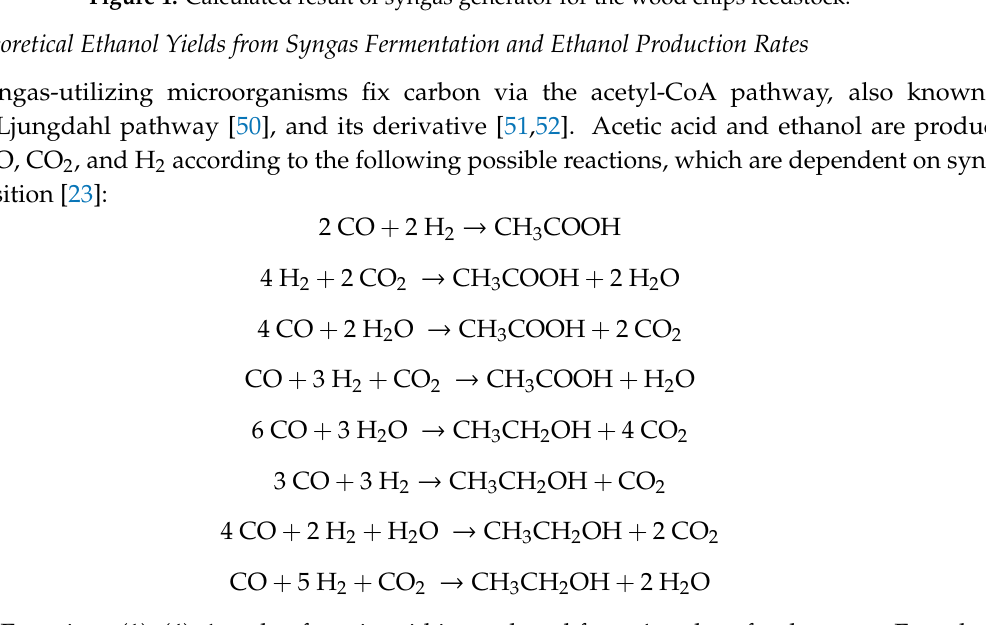
Figure 1. Calculated result of syngas generator for the wood chips feedstock.